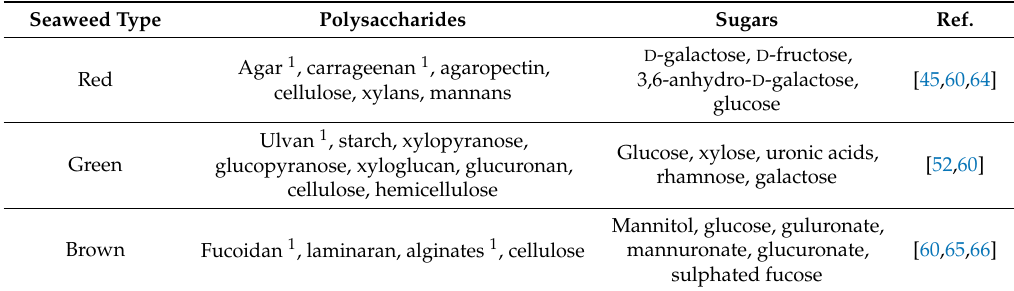
Table 1. Sugars and polysaccharides in red, green, and brown